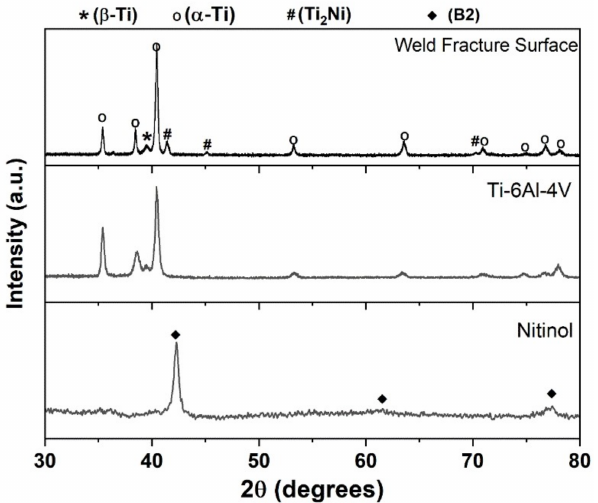
Figure 7. X-ray diffraction (XRD) profiles of the Ti-6Al-4V base metal, Nitinol base metal and fracture surface of the Ti-6Al-4V/Nitinol friction